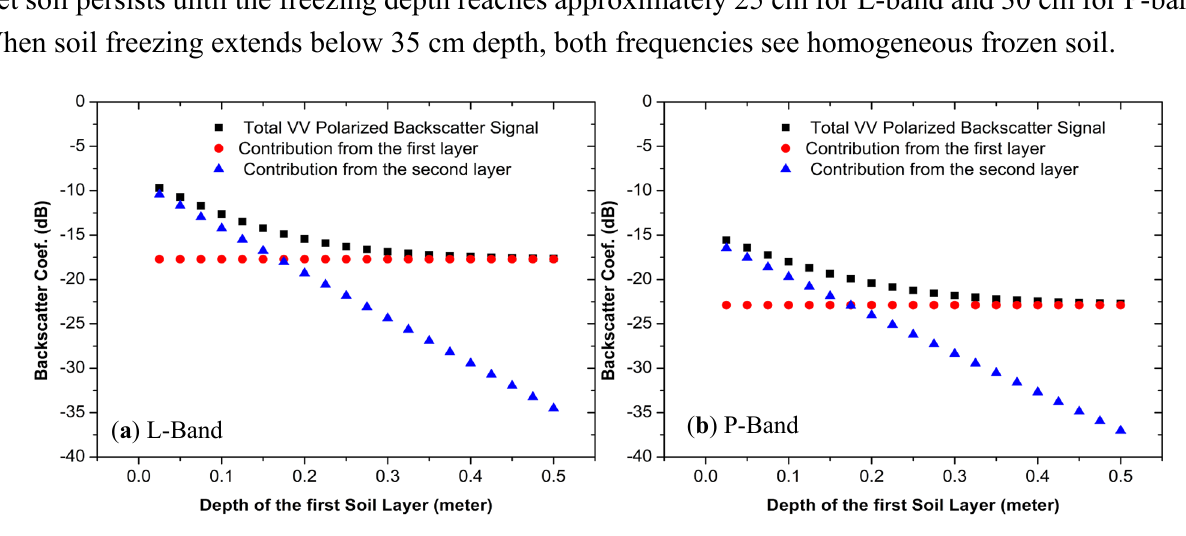
Figure 6. Total backscatter and associated dB contributions from different soil layers with varying first-layer depth for VV polarization at ( a ) L-band and ( b ) P-band simulated by the FTSS